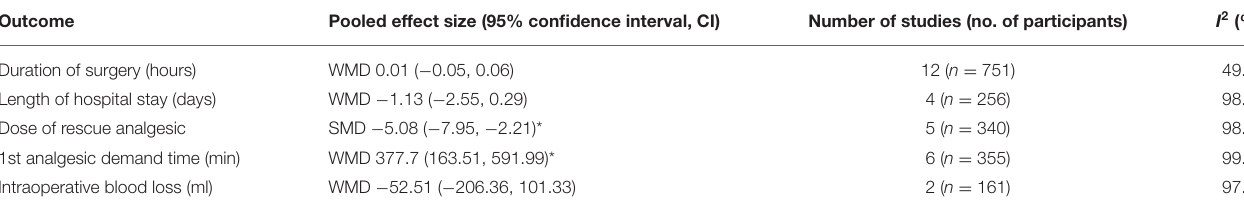
TABLE 2 | Summary of pooled findings related to additional outcomes of interest. Outcome Pooled effect size (95% confidence interval,